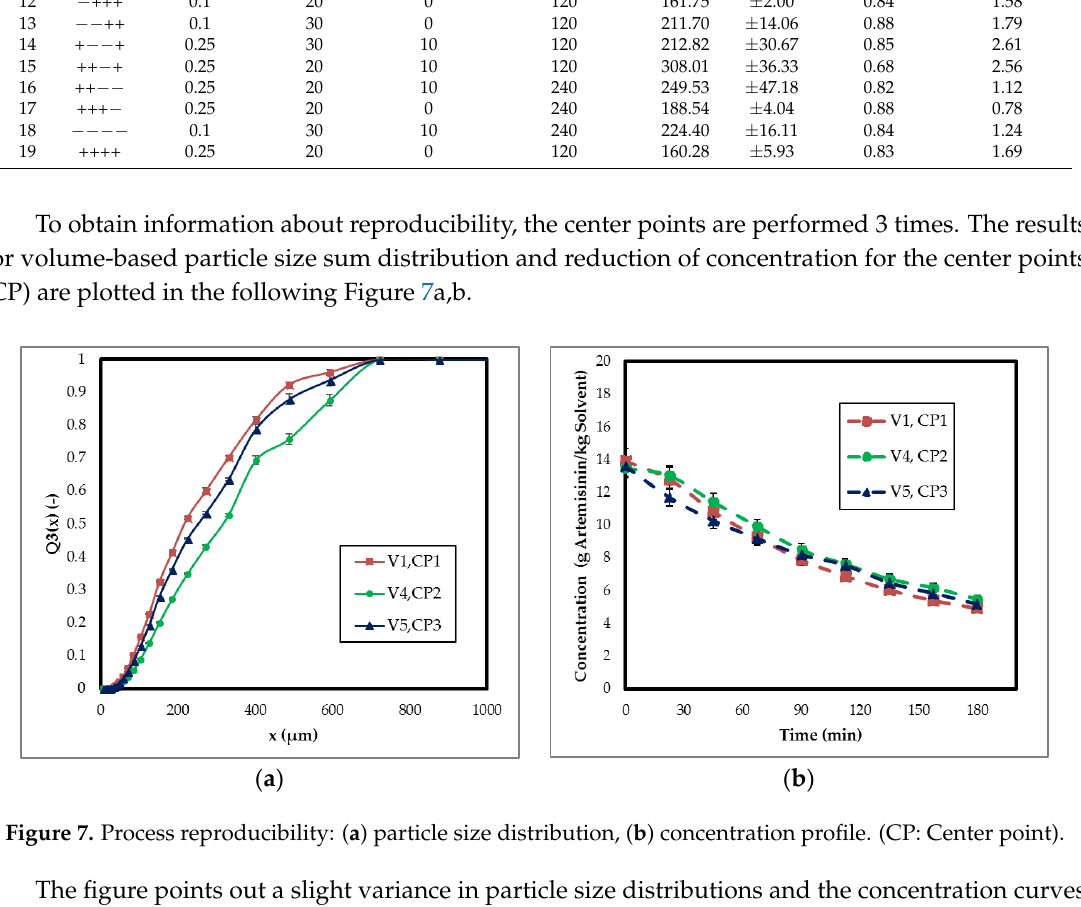
Table 4. Design of experiments for growth experiments (STY: Space-Time-Yield; TDL: Thermodynamic limit). Pattern